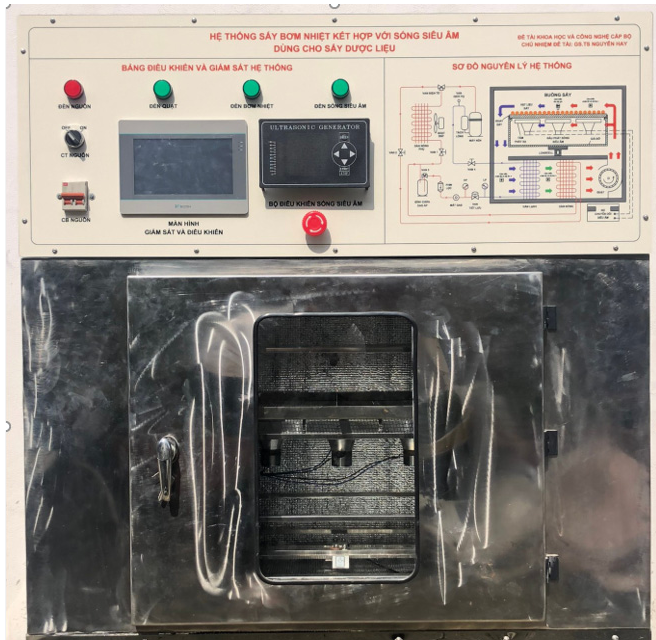
Figure 2. Actual self-fabricated model of ultrasound-assisted heat pump dryer.